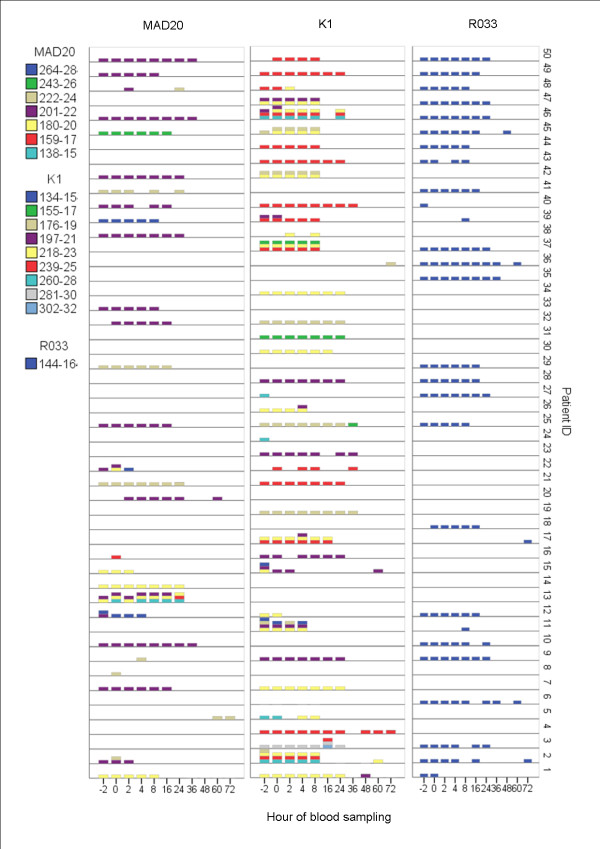
Distribution of detectable msp1genotypes over time for each study participant